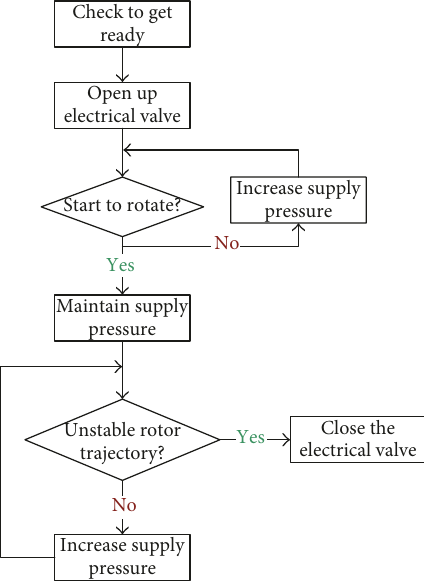
Figure 9: Testing process of the turboexpander with protuberant foil journal and thrust